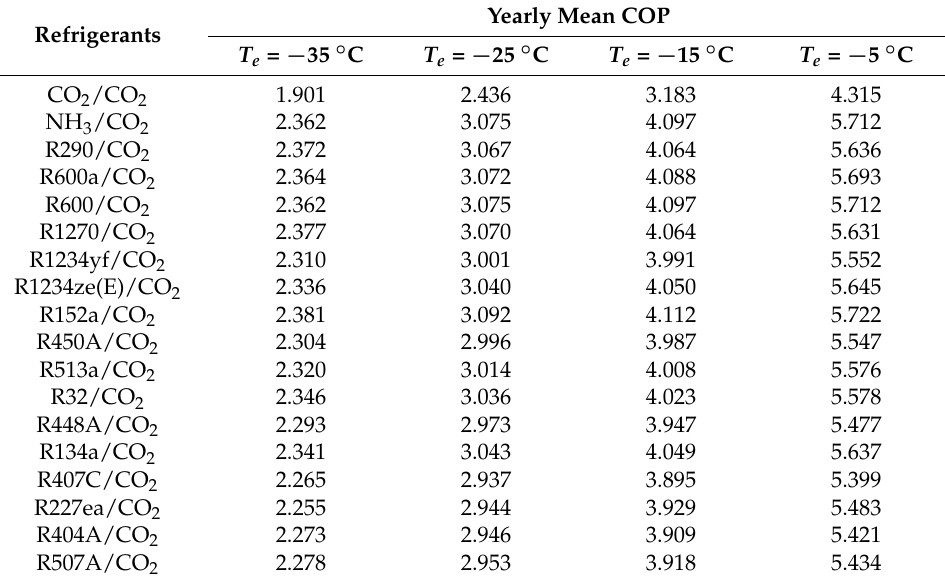
Figure 9. Mean yearly COP of four cases for different evaporator temperatures. Table 3. Yearly values of the mean COP for the examined cases.